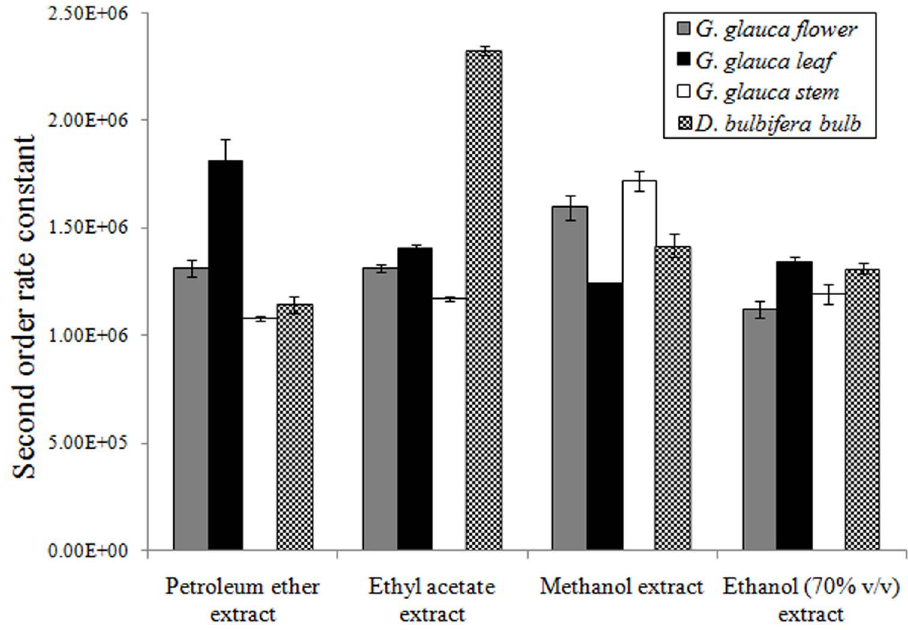
Figure 2. Pulse radiolysis generated ABTS N + radical scavenging by plant extracts.